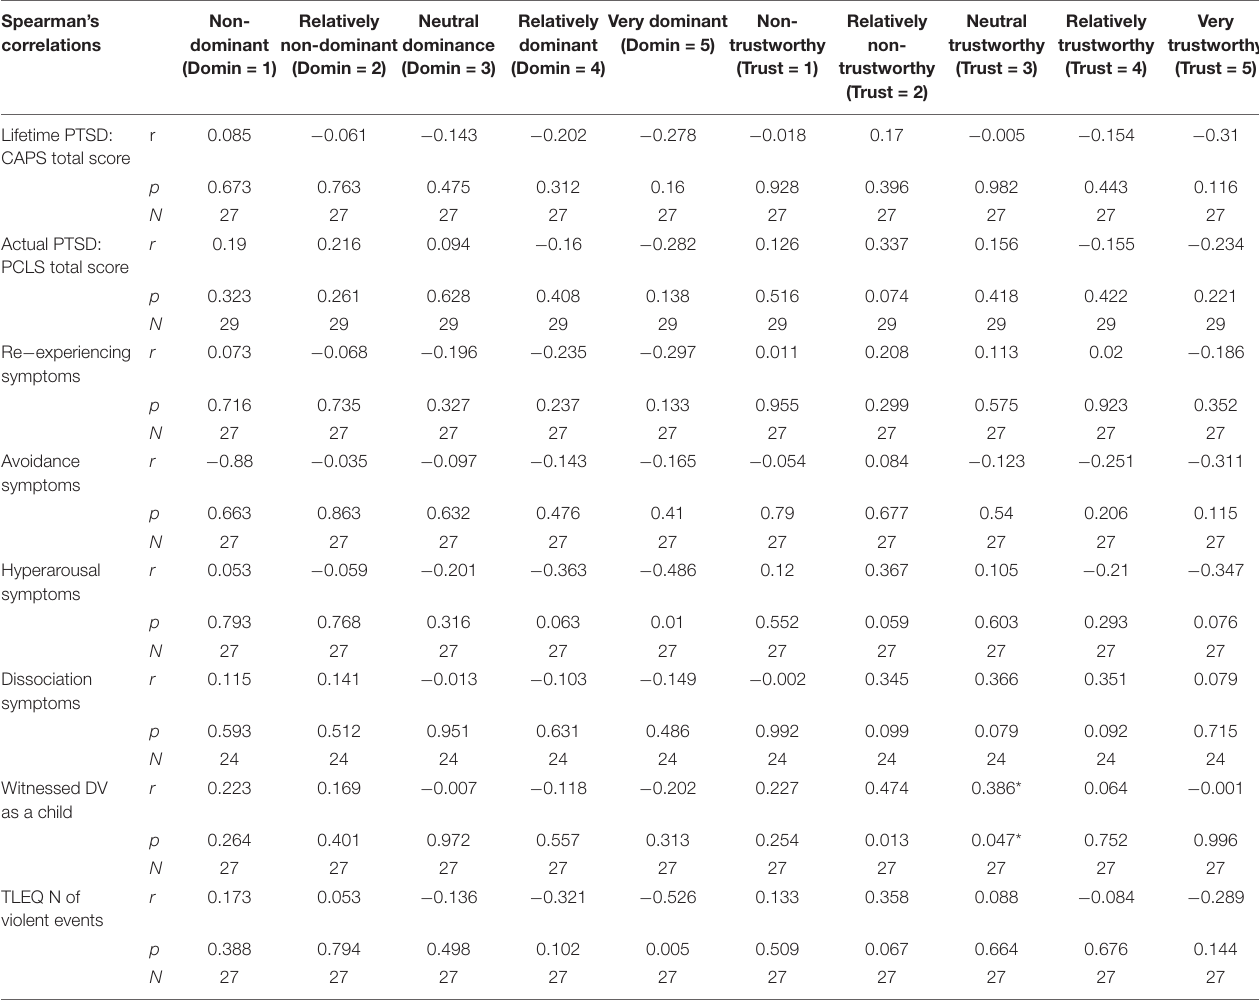
TABLE 2 | Spearman’s correlations between participants psychopathology, exposure to violent events,and avatar’s evaluation. Spearman’s